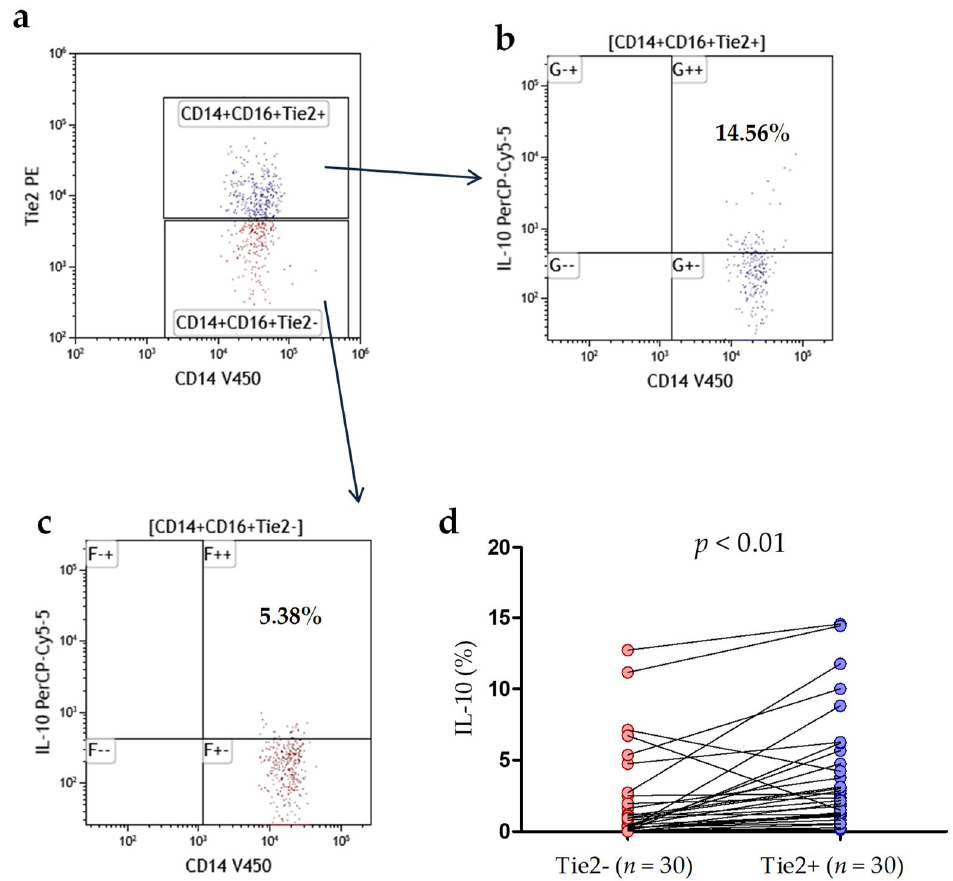
Figure 7. Intracellular IL-10 expression in CD14+CD16+Tie2+ (TEM) and CD14+CD16+Tie2- mono- cytes. ( a ) The dot plot (CD14 V450 vs. Tie2 PE) indicate Tie2-positive cells (TEMs; blue). Addi- tionally, the population CD14+CD16+ without Tie2 expression was gated (CD14+CD16+Tie2-; red). CD14+CD16+ monocytes were selected as was shown in Figure 1a–f. Then the Tie2-positive (TEM) ( b ) and Tie2-negative ( c ) cells were analyzed for intracellular IL-10 expression. FMO (Fluorescence Minus One) control was used to set proper gates. Data were analyzed using Kaluza 2.1.1 software. ( d ) Percentages of Tie2-positive (TEMs) and Tie2-negative cells with intracellular IL-10 expression in 30 CLL patients. TEM, Tie-2 expressing monocytes; SCC side scatter.